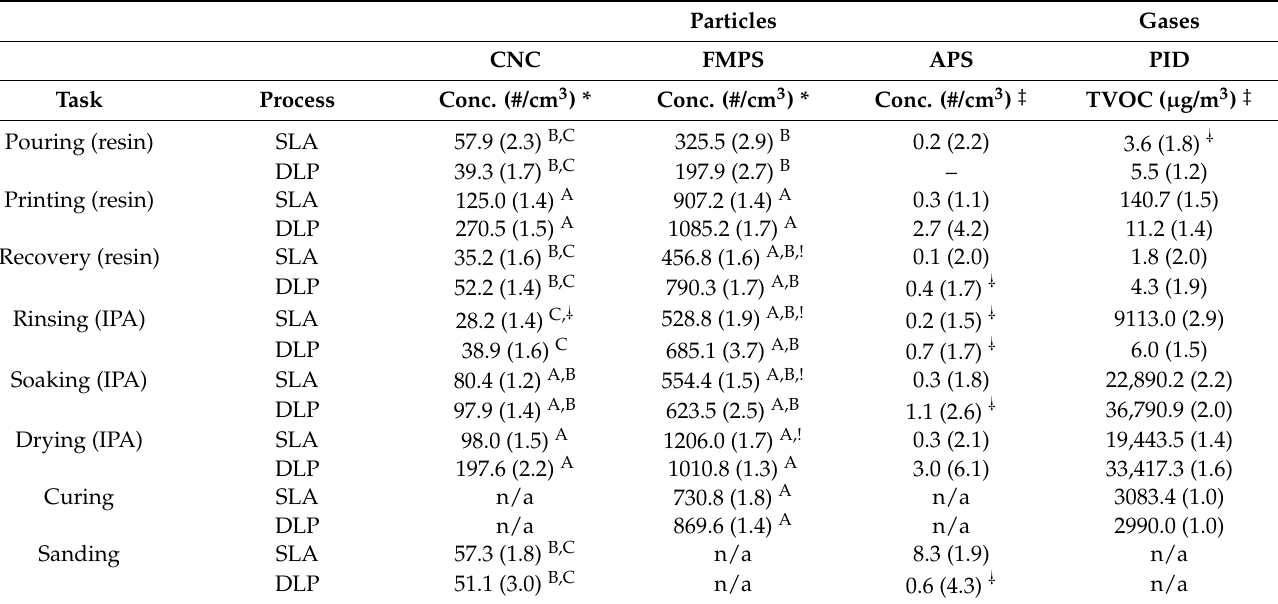
Table 3 gives the GM maximum particle number and TVOC concentrations. Maximum values exceeded background levels for all tasks, except the pouring task APS data for the DLP process. Table 3. Geometric mean (geometric standard deviation) maximum background-corrected particle and total volatile organic compound (TVOC) concentrations by process and task (n = 5 replicates).